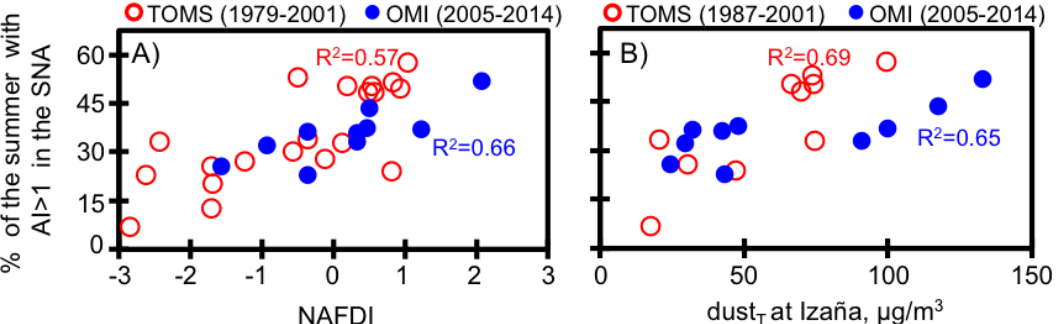
Figure 7. Scatterplot of summer dust activity in the subtropical North Atlantic versus the NAFDI. MDAF in the subtropical North Atlantic (SNA) versus the NAFDI (a) and versus dust T at Izaña (b) . Measurements of the TOMS (red circle) and OMI (blue dot) satellite-borne sensors were used. The R 2 coefficient of the linear fitting is included.